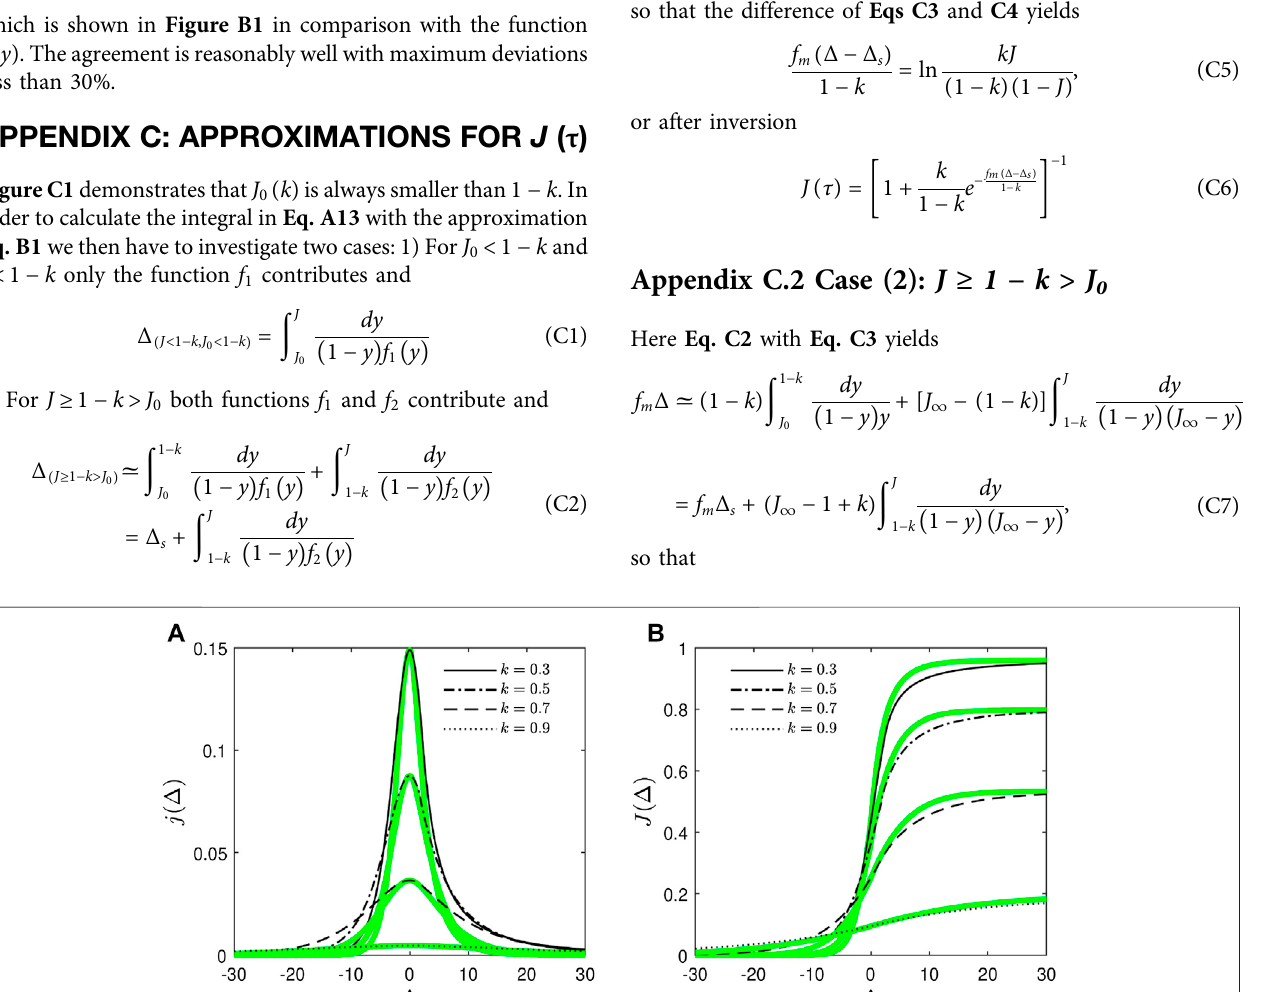
Frontiers in Physics |